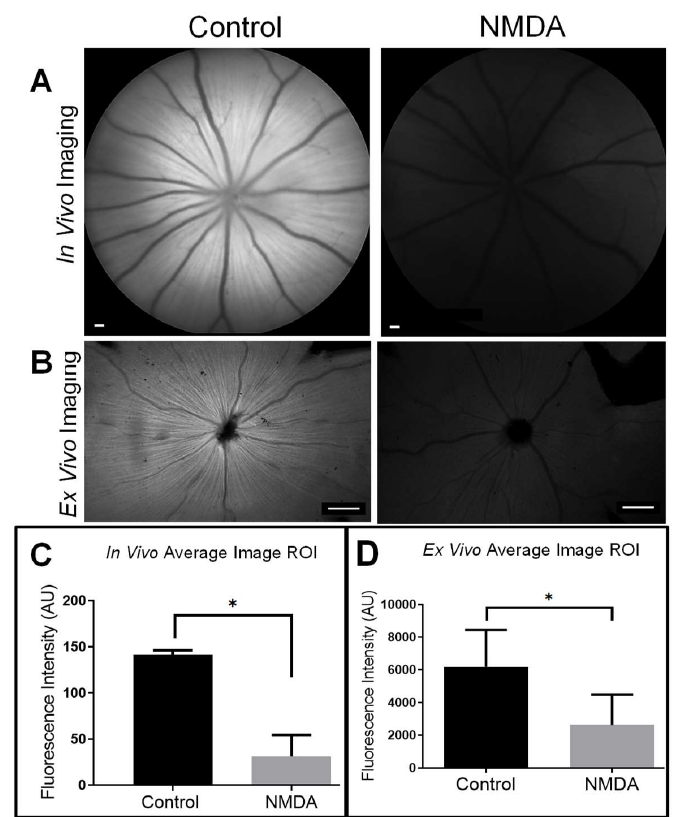
Figure 1. Axonal transport is impeded in a neurotoxic rat eye model. ( A ) An in vivo fluorescent image of the fundus of the eye, ( B ) and an ex vivo retinal flat mount illustrates control versus NMDA-treated eyes 3 h after an intravitreal injection of TTc-488 (8 µ g in 2 µ L PBS). Note the RA’s (radial linear pattern) centered on the optic nerve head in control eyes but markedly diminished in NMDA-treated eyes. The RGCs (foci pattern) are visible in the ex vivo image of control eyes only. Early retinal damage manifests as failed TTc-488 uptake and transport in retinopathic eyes. Note the close correspondence between in vivo ( n = 3) and ex vivo ( n = 5) quantitative findings in the ( C ) average fluorescence intensity for the in vivo control (141.67 AU ± 4.65) vs. NMDA-treated eyes (31.28 ± 23.18) (Mean ± SD) ( p = 0.02, t = 7.192) and ( D ) ex vivo control (6185.09 AU ± 2262.34) vs. NMDA (2626.68 AU ± 1860.79) (Mean ± SD) ( p = 0.03, t = 3.700) images compared with paired 2-tailed t-tests confirming a significant di ff erence in TTc-488 uptake and transport between control and NMDA-treated eyes. Scale bars